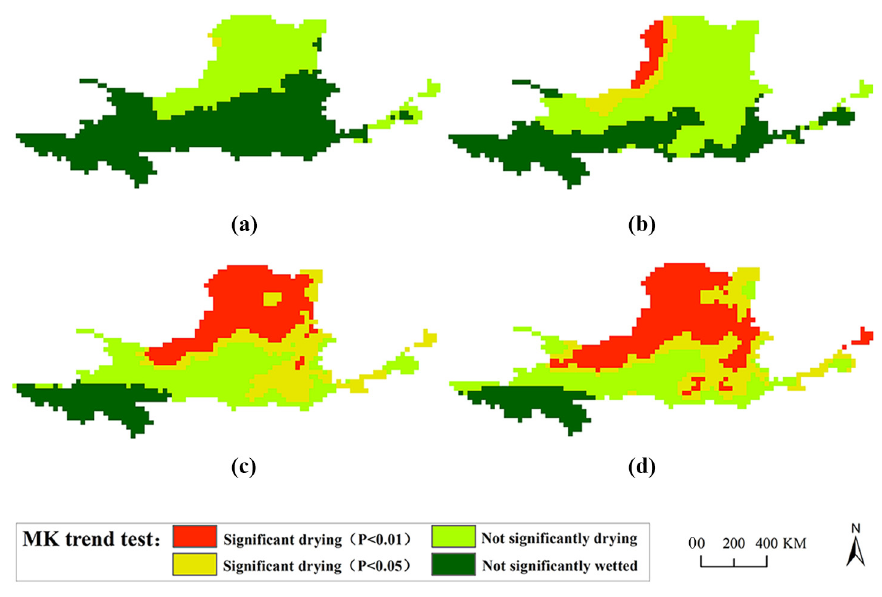
Figure 2. Relationships between observed annual precipitation (a), mean temperature (b) and simulated values under RCP4.5 scenario